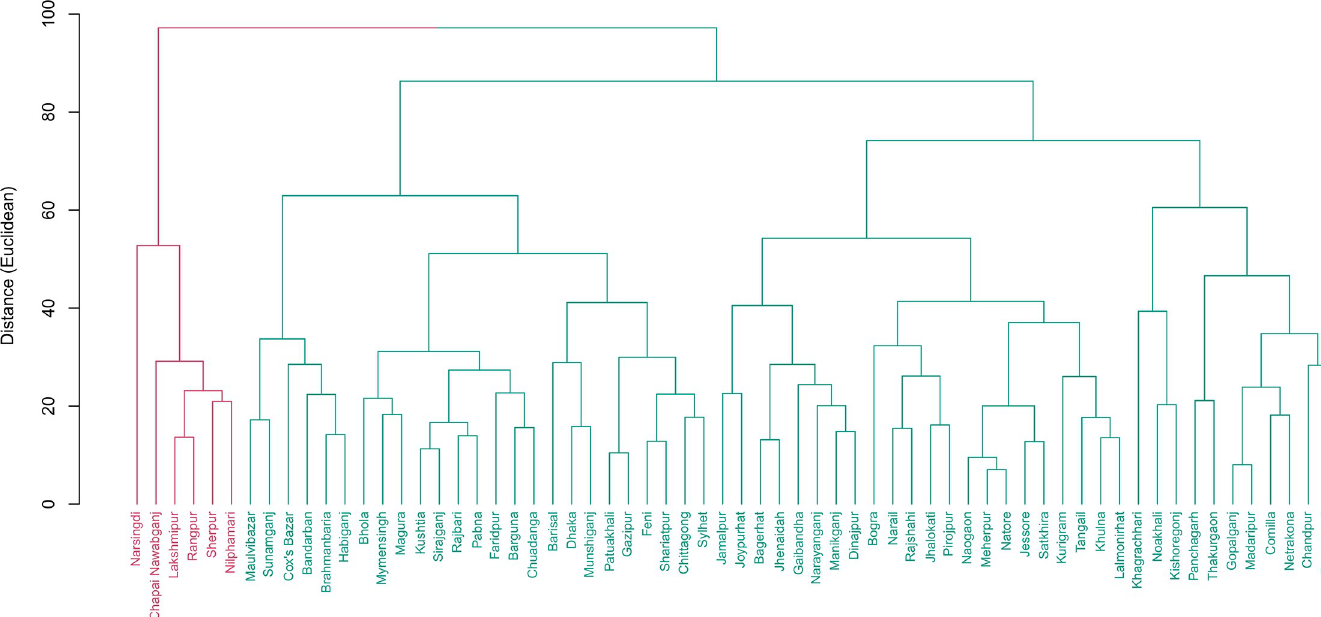
Fig 3. Cluster of districts based on child protection and development indicators. Two clusters were found. Cluster 1 include 58 districts while 6 districts were in cluster 2. Percentage of women married before age 15 is 34.2 in cluster 2 which is 10 percentage point higher than national average (23.8%).